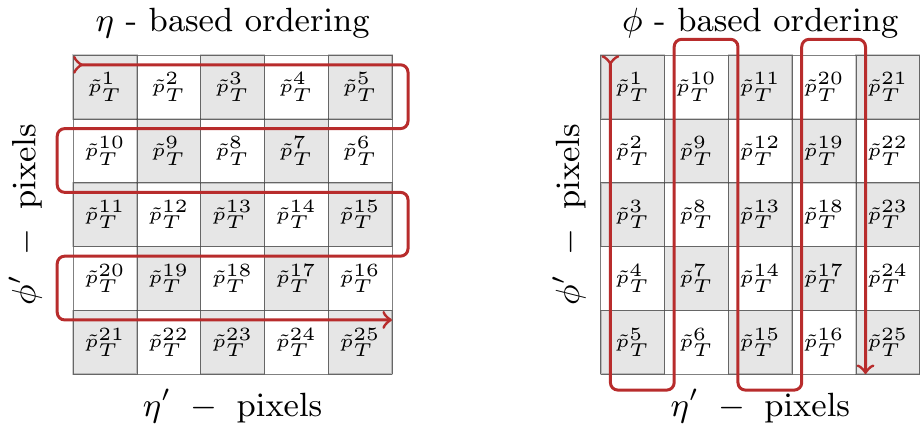
Figure 8 . The reshaping procedure has been shown to map the image on the 1D lattice. For simplicity, only 5 × 5 portion of the image has been